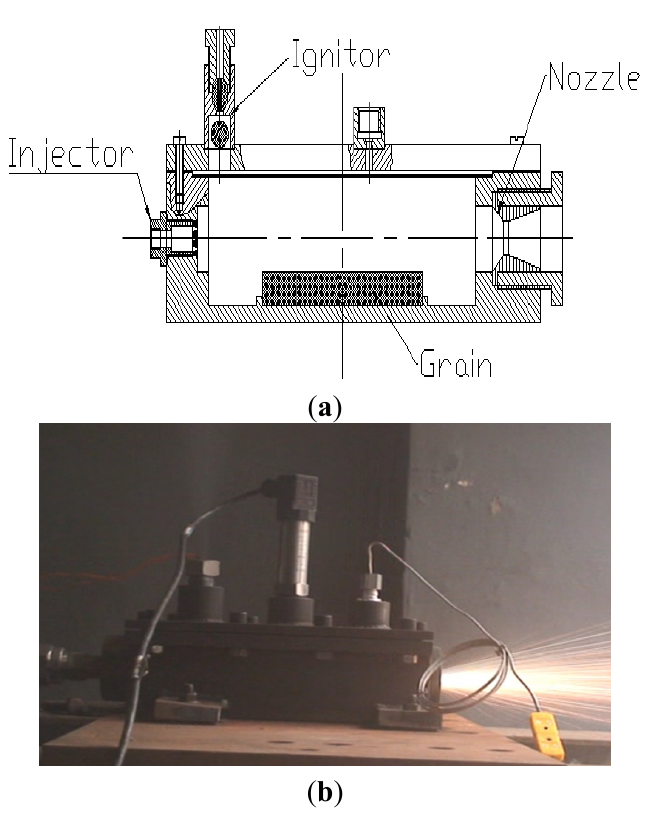
Figure 18. The sketch of the rectangular engine and the photo of the paraffin-based fuel’s ignition experiment. ( a ) Structure sketch map; ( b ) working